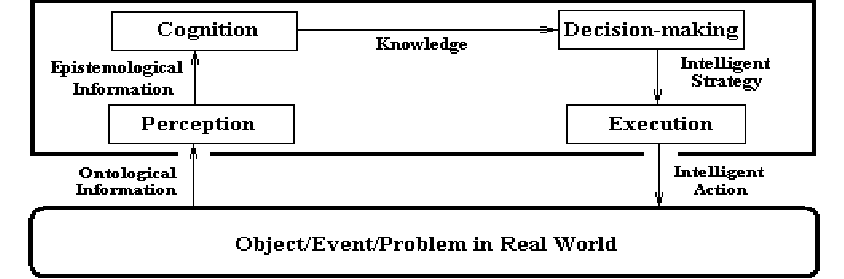
Figure 1. Model of Information Ecology